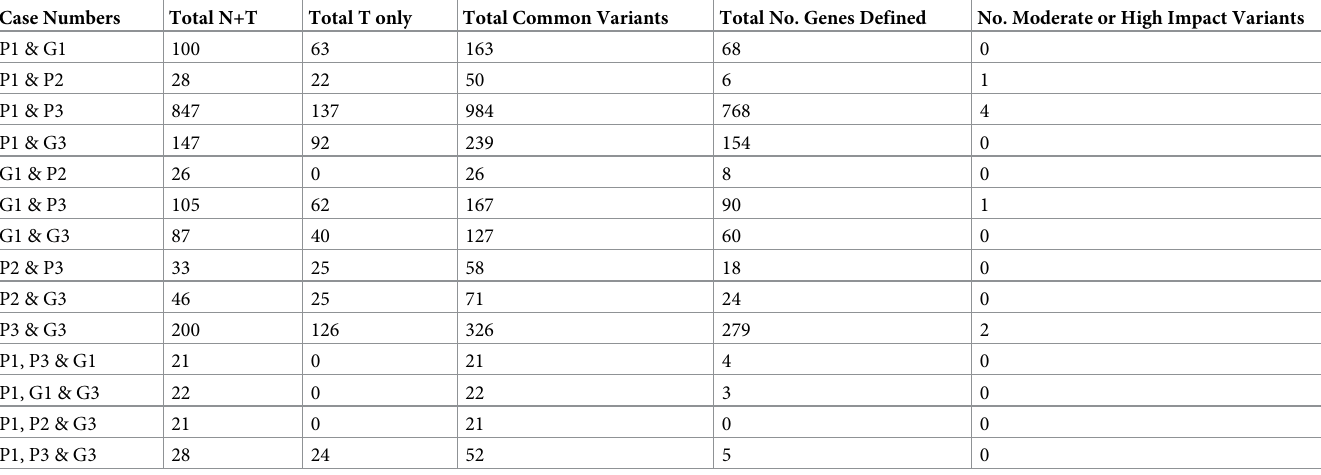
Table 4. Common variants in subsets of